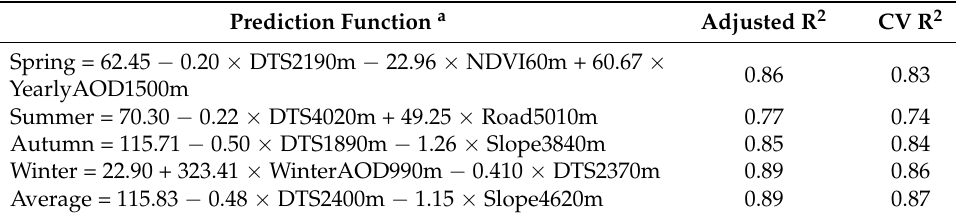
Table 1. LUR models for seasonal PM 2.5